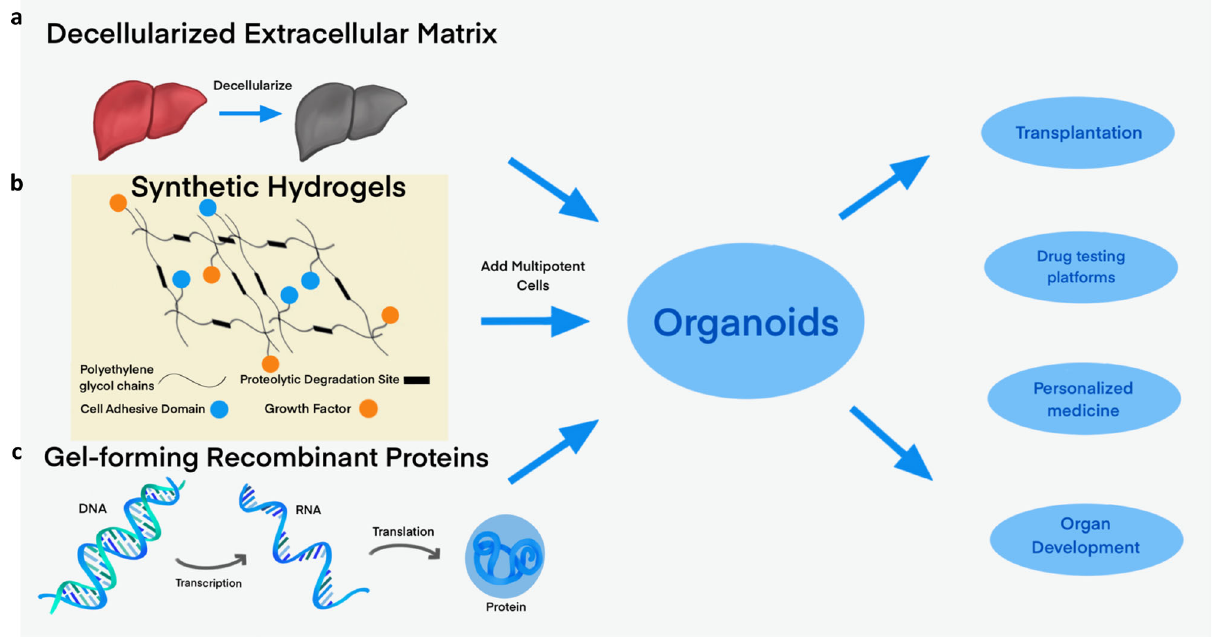
Fig. 1 Methods of making organoids without Matrigel. Replacing the unde fi ned medium of Matrigel is a major goal of organoid culture. We will discuss three main alternative media: ( a ) decellularized extracellular matrix and other derived proteins, ( b ) synthetic hydrogels, which generally incorporate cell- adhesive domains or proteolytic degradation sites, and ( c ) gel-forming recombinant peptides. Adding multipotent cells to these matrices enables the growth of organoids, which are potentially applicable as transplants, drug-testing platforms, personalized medicine, and means to understand organ